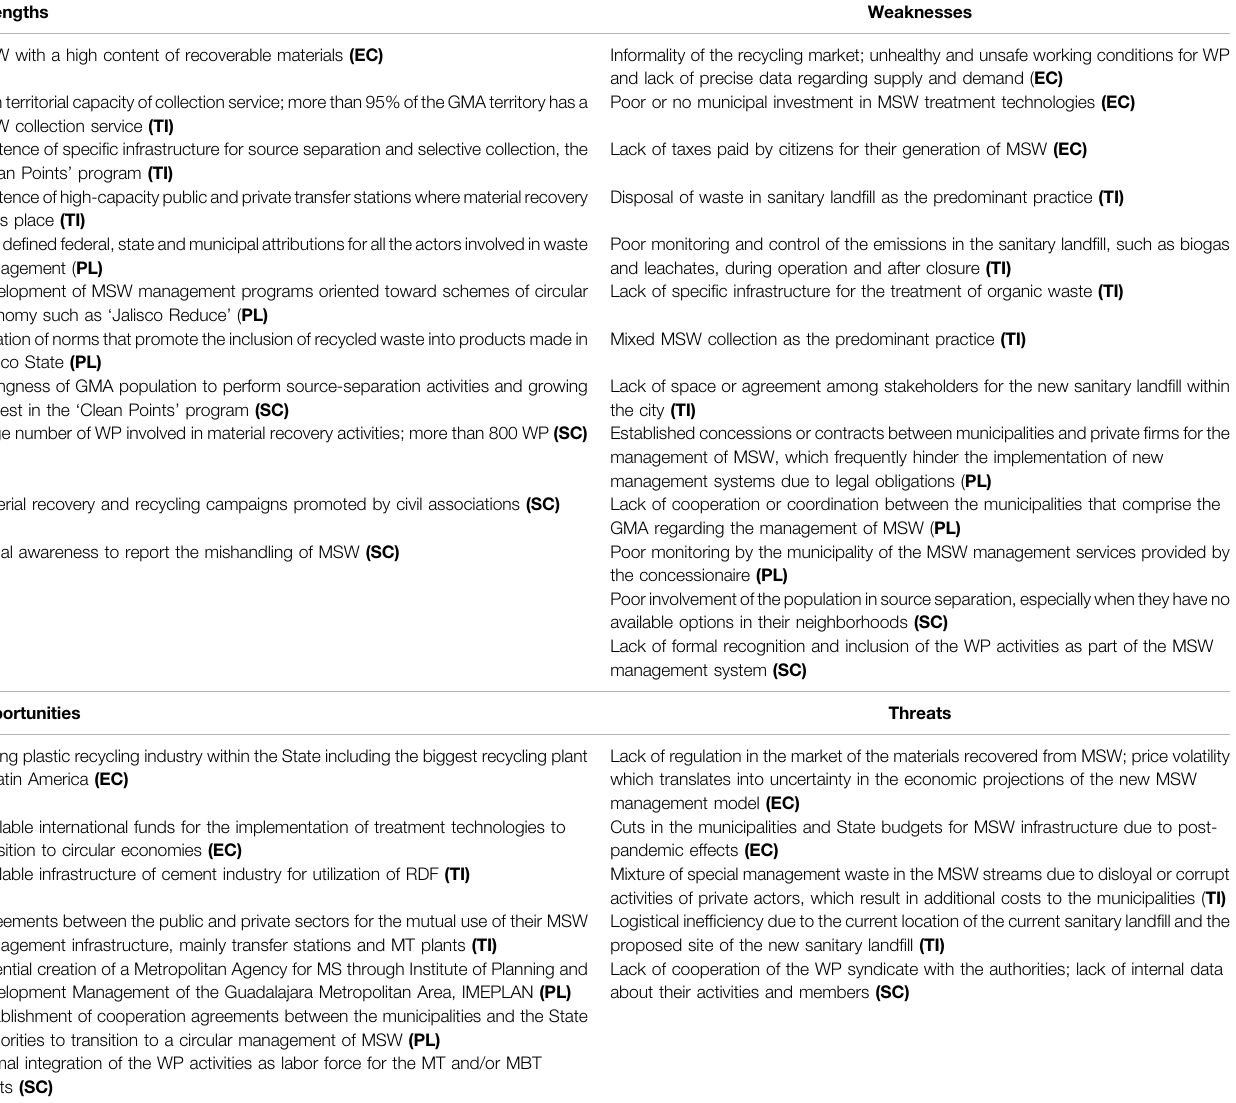
TABLE 5 | SWOT analysis of the current GMA MSW management